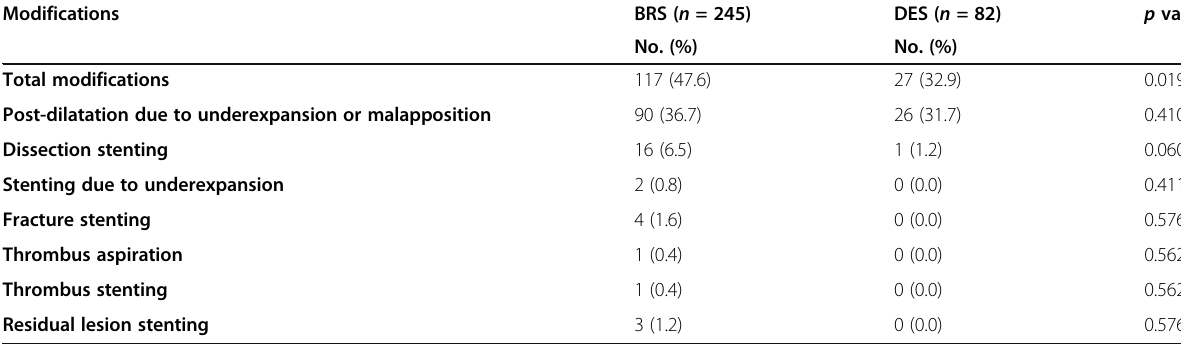
Table 3 Comparison of OCT-guided modification in BRS vs.